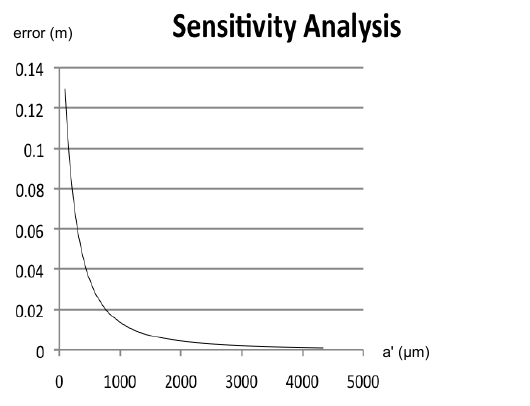
Figure 19. Sensitivity